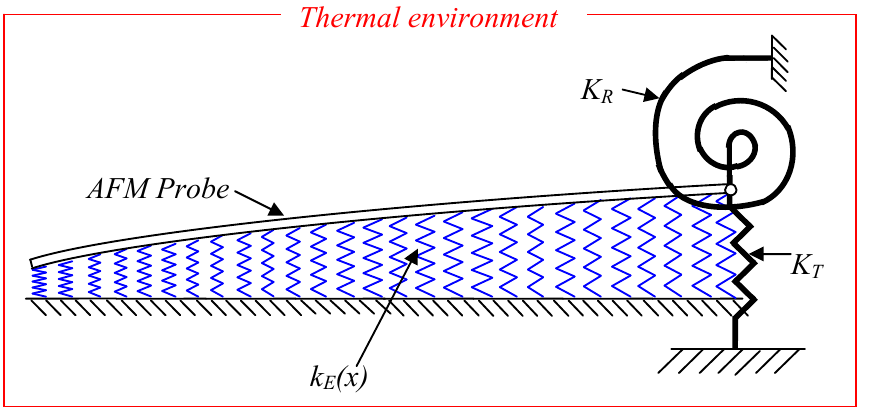
Figure 3. Environmental influences on an AFM cantilever modeled with artificial